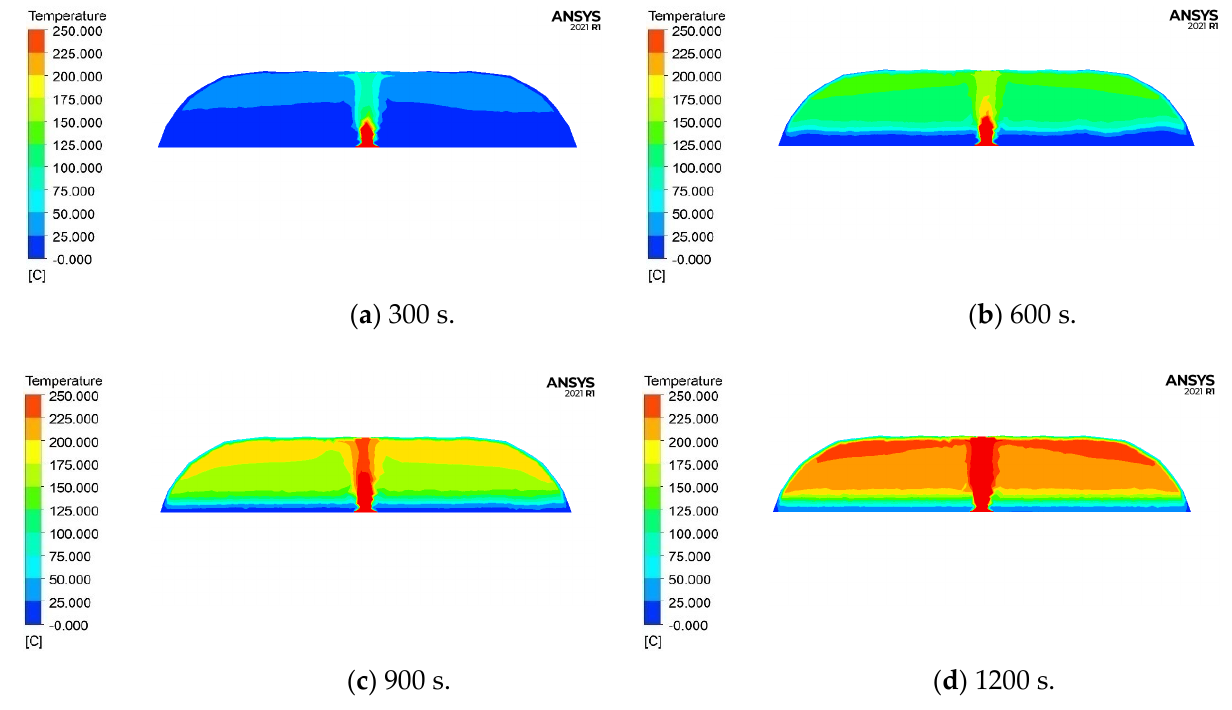
Figure 5. Temperature of the structure in the fast-grow fire event.